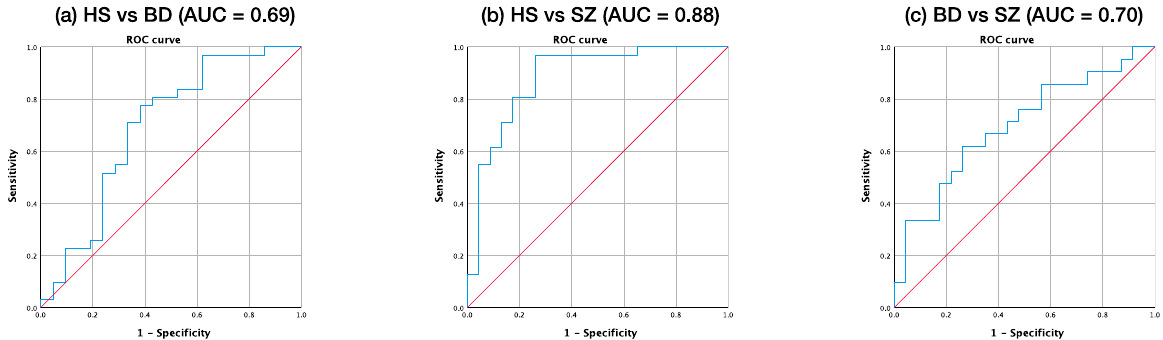
Figure 4. Receiver operating characteristic (ROC) curve of relative volumes of the right hippocampi between ( a ) HS and BD, ( b ) HS and SZ, and ( c ) BD and SZ. The area under the ROC curve was 0.69, 0.88, and 0.70, respectively.